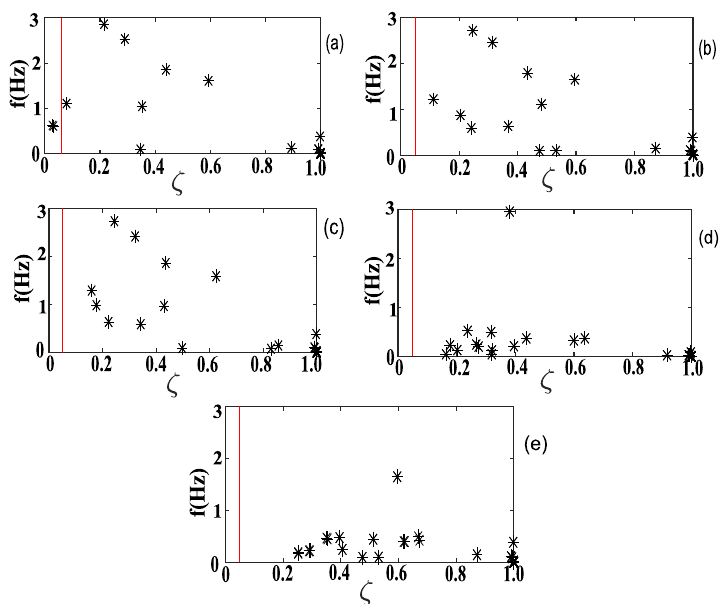
Fig.4 Plot of eigen modes:( a ) Open loop system ( b ) Single output WRDC; ( c ) WRDC with two outputs; ( d ) Three output WRDC; ( e ) Four output WRDC actuators and feedback signals used in tuning of WRDC are listed in Table 2 & shown in Fig. 3.